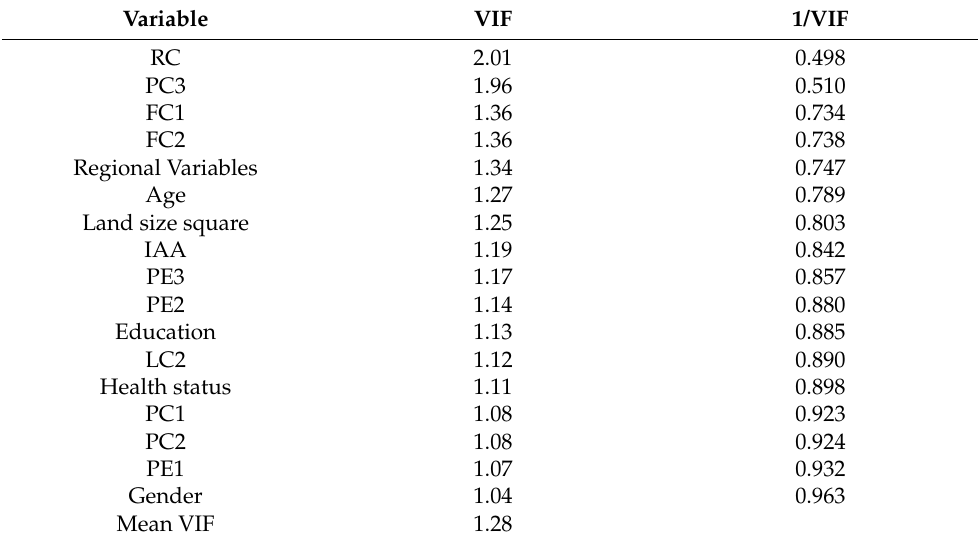
Table A1. Variance inflation factor of each variable.